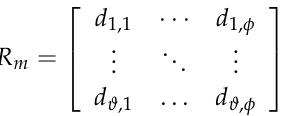
where d ϑ , φ is the parameter of each polar grid, and ϑ represents the number of vertical-angle grids. This is determined by the number of LiDAR detector modules. φ represents the number of horizontal-angle grids. The horizontal angle (l) of each polar grid is: